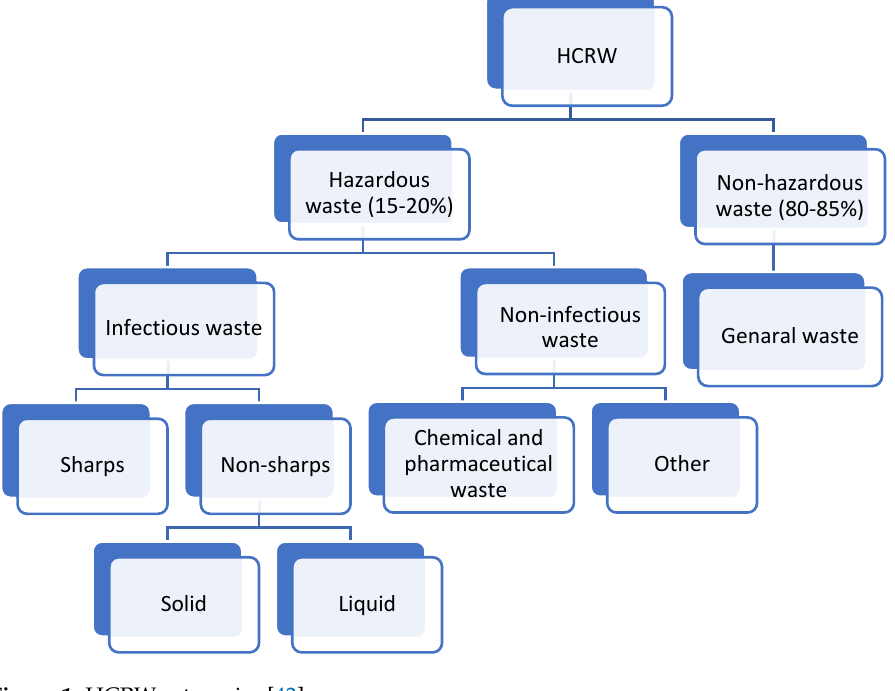
Figure 1. HCRW categories [42].